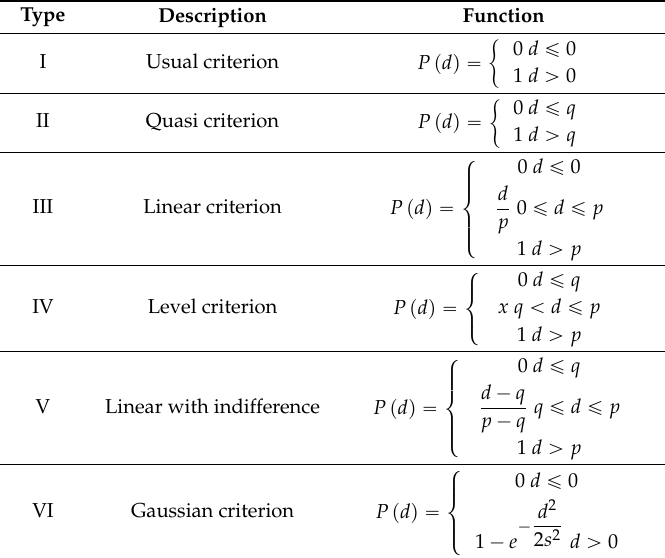
Table 2. PROMETHEE Criteria types